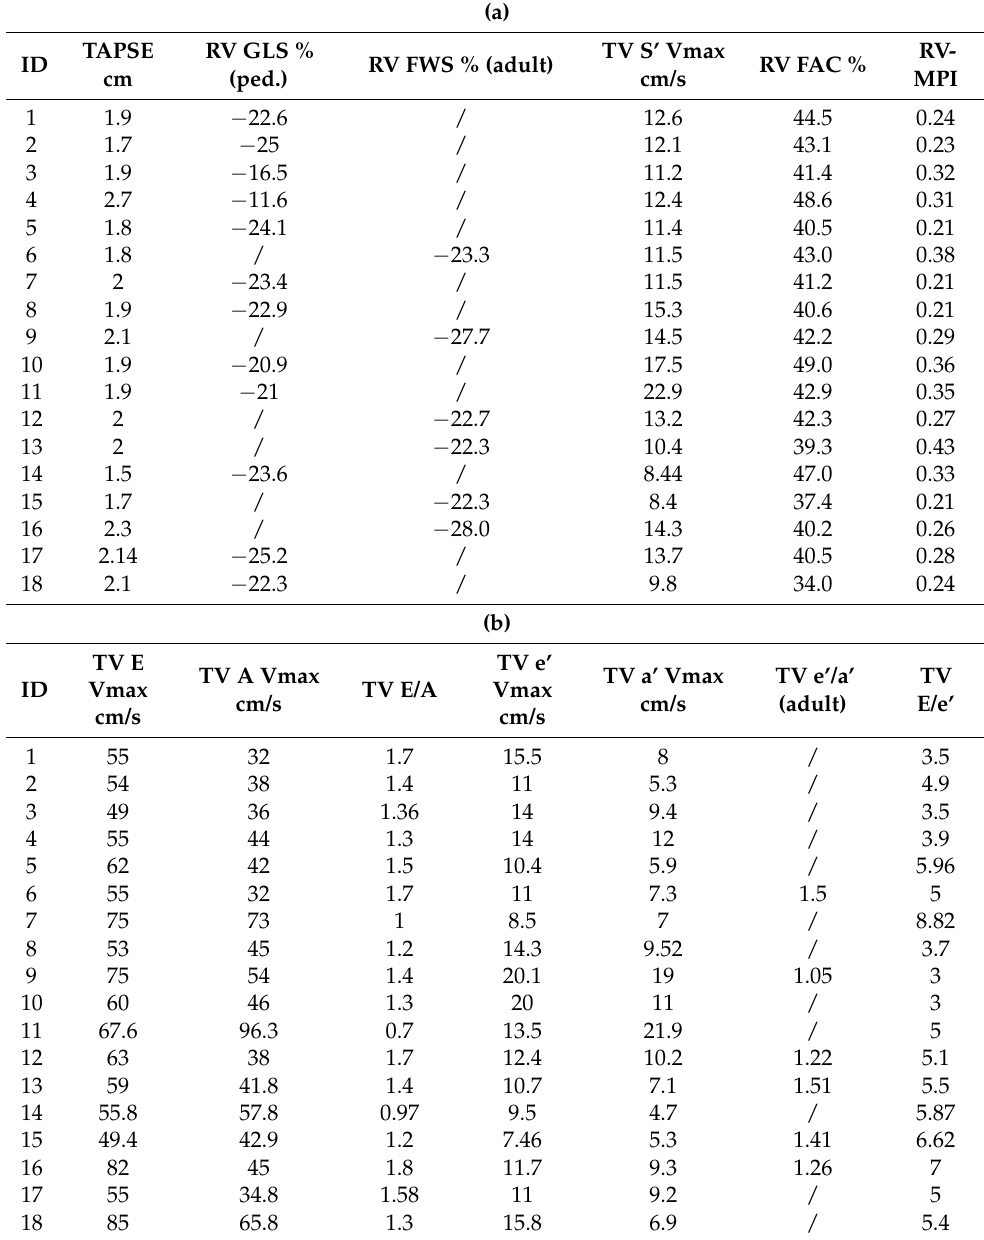
Table A1. ( a ) . Raw data of echocardiographic measurements for systolic RV function. ( b ) . Raw data of echocardiographic measurements for diastolic RV